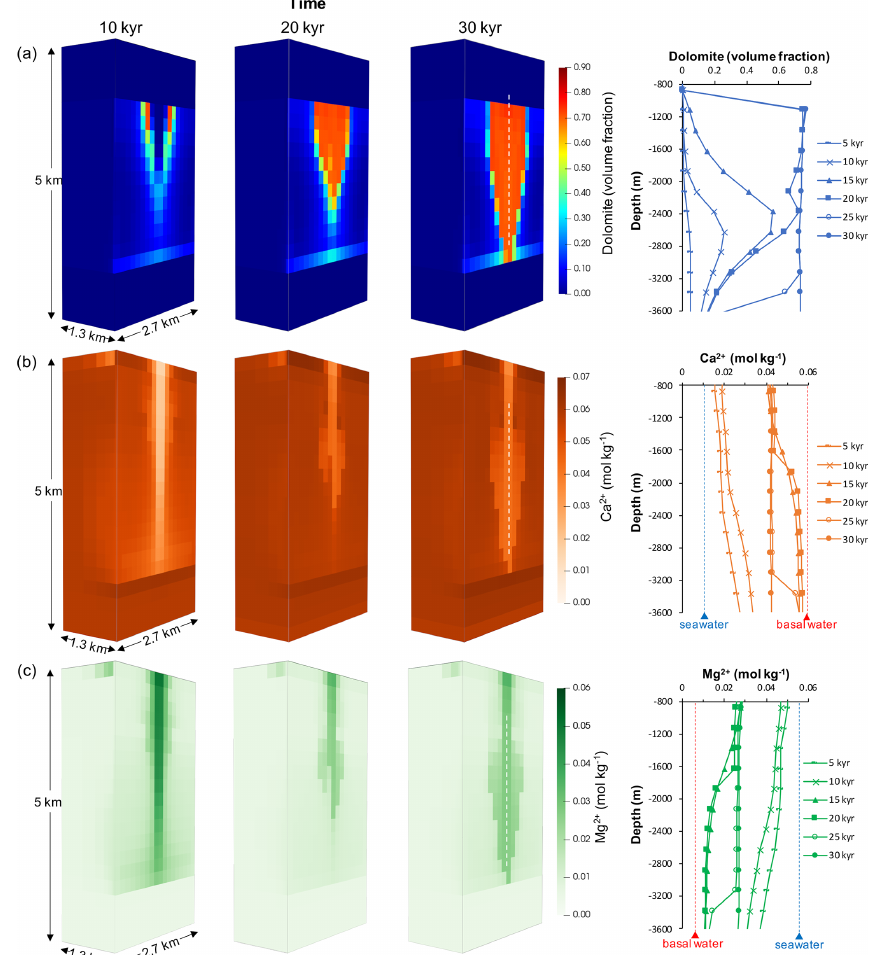
Figure 4. Temporal evolution of the dolomite volume fraction (a) , the Ca 2 + concentration (b) , and the Mg 2 + concentration (c) from the 3D baseline simulation, and plots of those changes down the core of the descending limb of the convection cell within the FDZ (white dashed line). Ca 2 + is enriched relative to seawater, and Mg 2 + is depleted as a result of the replacement of precursor limestone by dolomite. After complete replacement, there is a minor decrease in the concentrations of both Mg 2 + and Ca 2 + due to dolomite